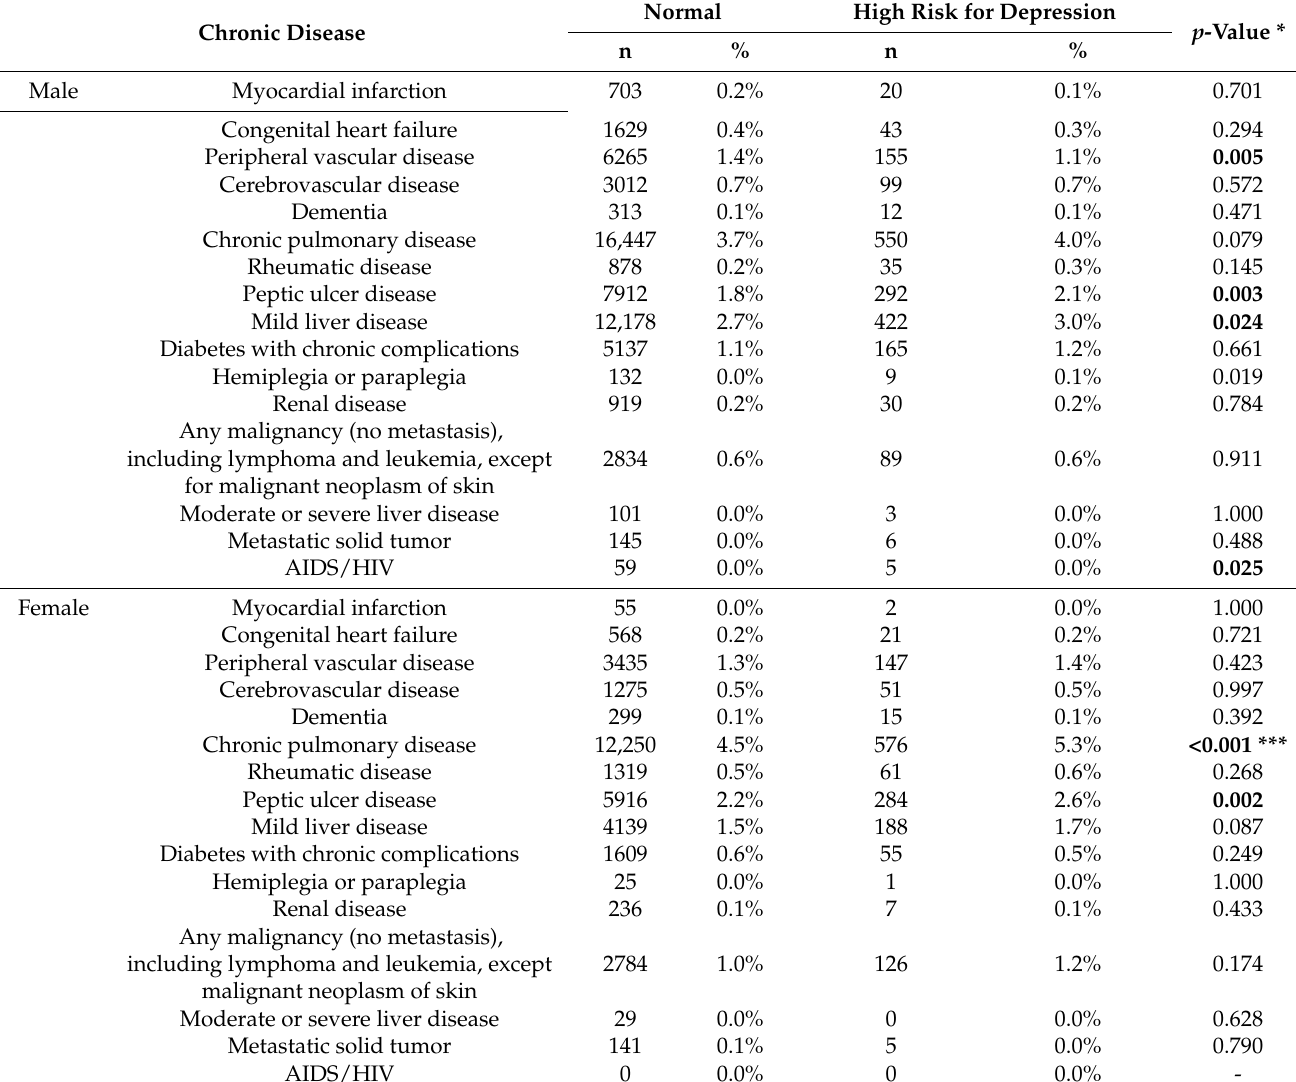
Table 4. Comparison of the prevalence of comorbidities according to PHQ-9 scores.